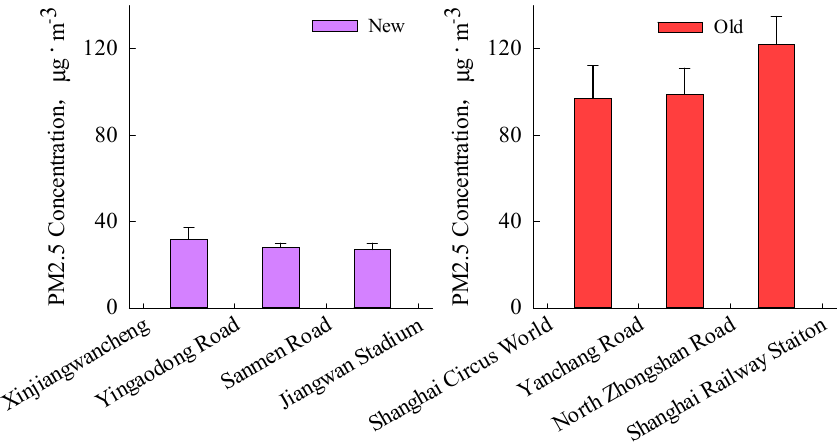
Figure 3. Average PM2.5 concentrations in metro carriages of line 1 (Old) and line 10 (New). The error bar indicates the standard deviation.